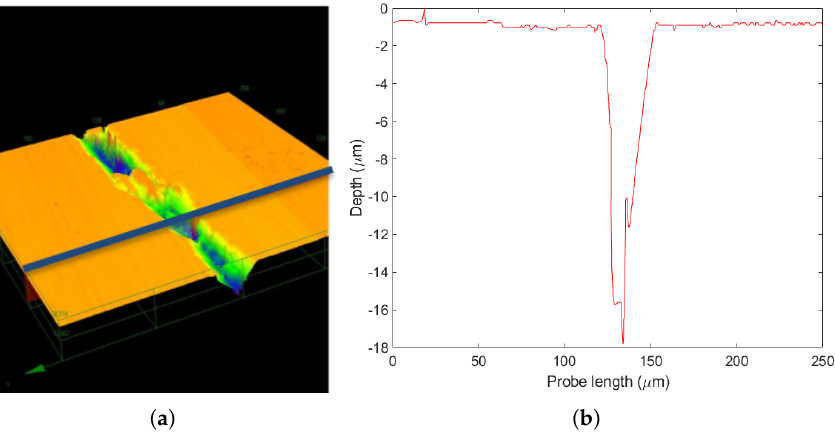
Figure 2. Laser profilometry on a Si − gf − Si structure: ( a ) laser probe path; ( b ) height